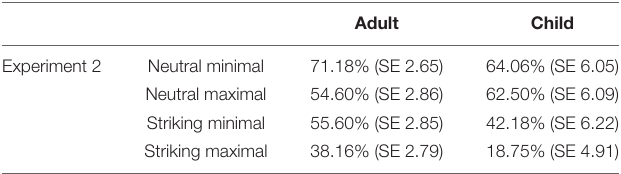
TABLE 4 | Mean percentage of property extension across conditions in Experiment